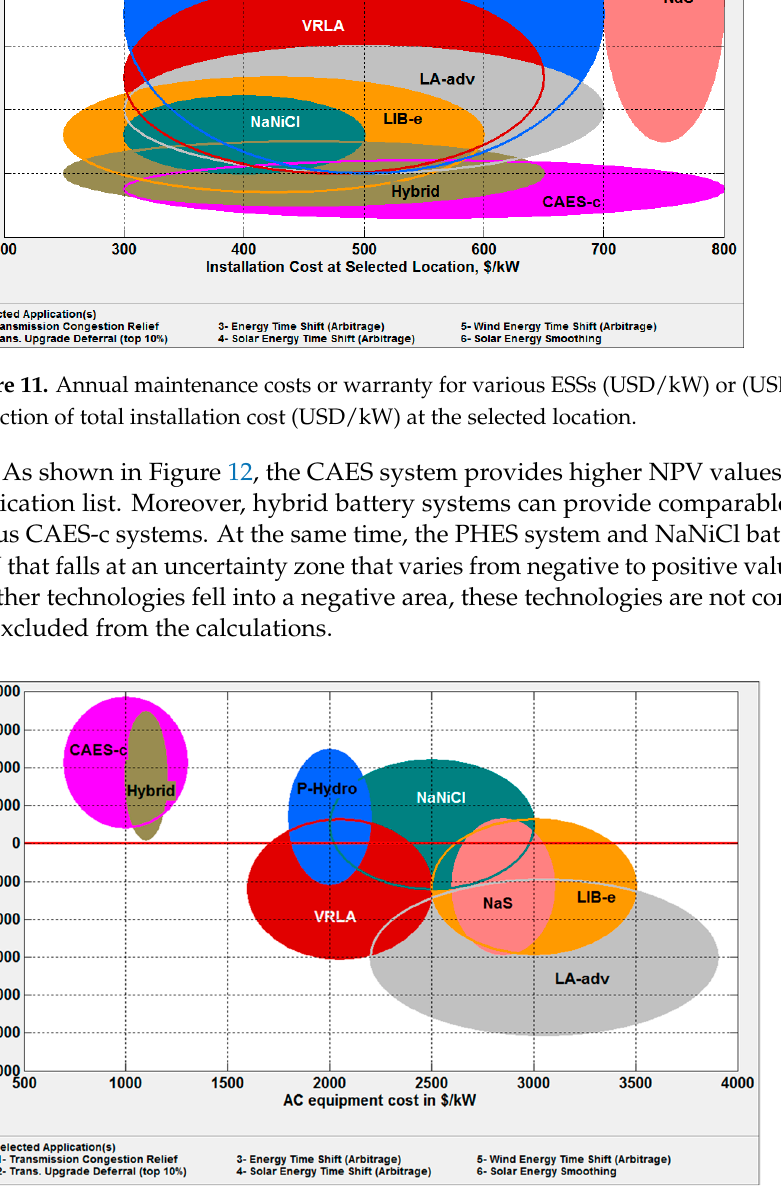
Figure 12. Net Present Value (USD/kW) as a function of the AC equipment cost (USD/kW) for the selected applications list.